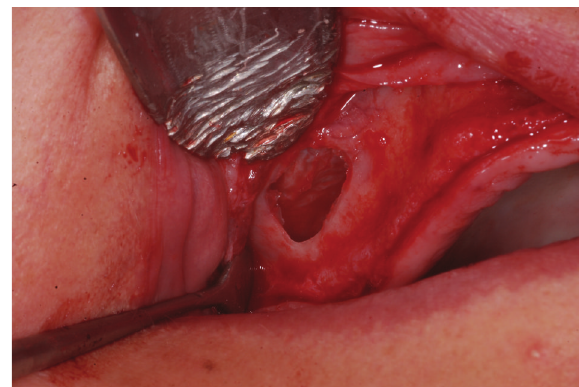
Figure 4: The Schneiderian membrane seen through the lateral window in the maxillary sinus.